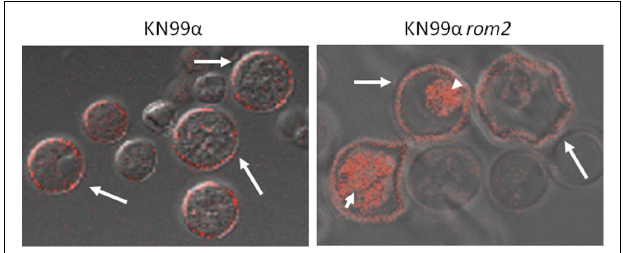
FIGURE 4 | Microscopy was used to visualize location of the PEI-ce6 in association with C. neoformans . Cells were grown at 37˚C, exposed to PEI-ce6 for 10min and then washed with PBS. Arrows indicate localization of the PEI-ce6 at the cell wall perimeter. Arrowheads mark the localization of PEI-ce6 within the interior of the cell.With wild-type cells (KN99 α ), the dye was confined to the surface of the cells. However, with the KN99 α rom2 mutant, the dye was able to penetrate the cell